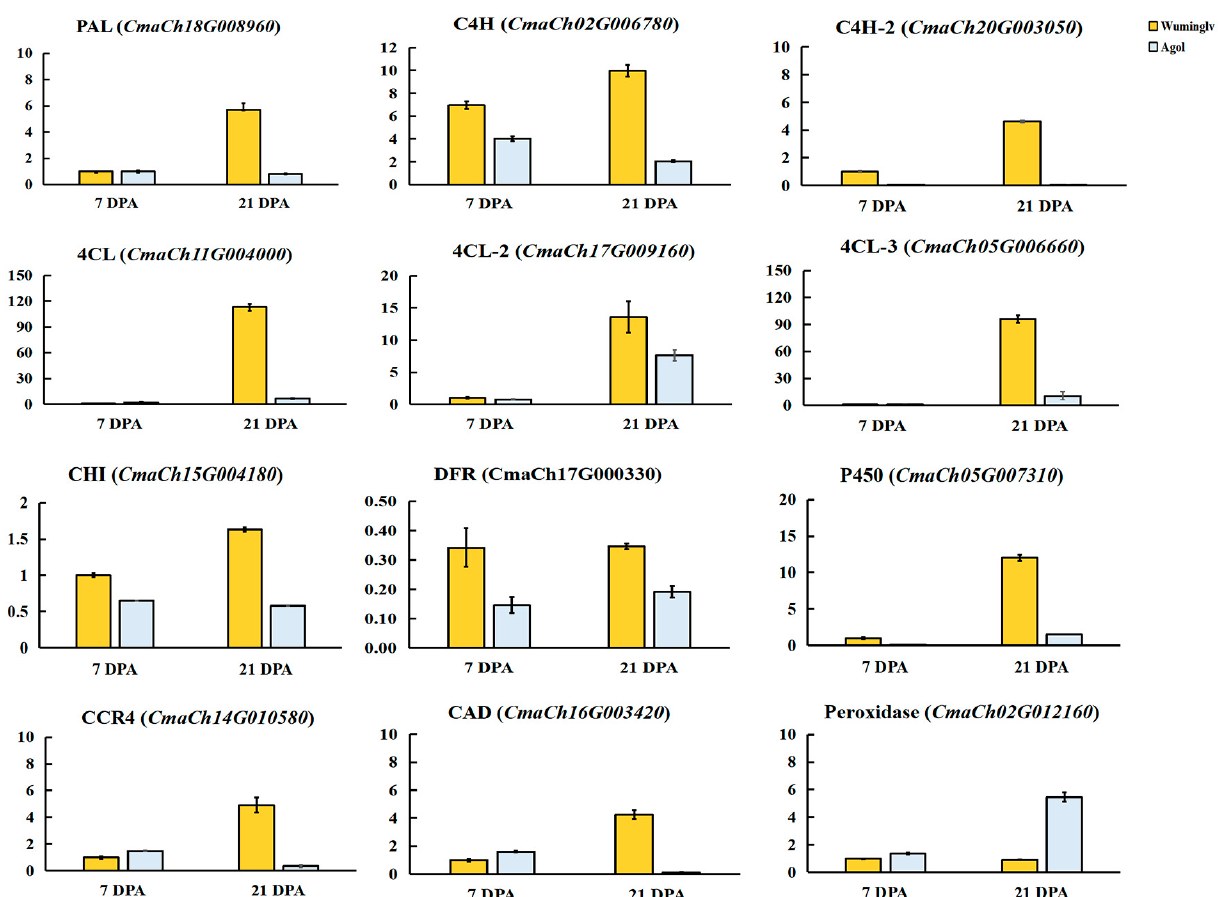
Figure 6. Expression patterns of twelve genes involved in phenylpropanoid/flavonoid metabolism pathway in Wuminglv and Agol seed coat.